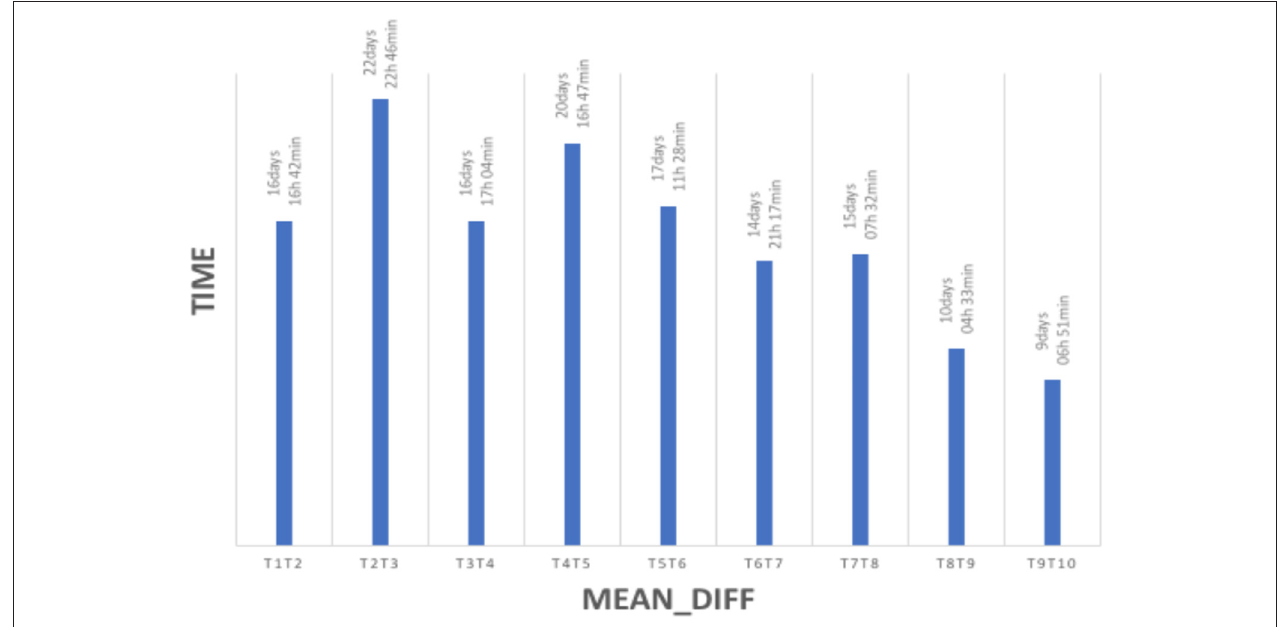
FIGURE 4 | Frequency distribution of session completion by dyads. MEAN_DIFF depicts the average timespan between sessions T1T2, T2T3… TIME indicates the amount of days, hours and minutes of the timespan between